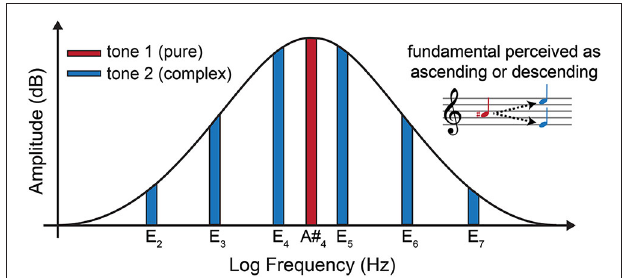
FIGURE 1 | Frequency spectrum diagram of the first (pure) tone (red) and the second (Shepard) tone (blue) of the bistable tritone stimulus employed in the current experiment . The horizontal axis is logarithmic reflecting perceptual as opposed to physical distances between frequencies. The musical staff (upper right) shows the two possible perceived pitch movements from tone 1 to tone 2. Due to the pitch ambiguity of tone 2, listeners perceive this pitch as either E 4 or E 5 , which results in ascending or descending pitch percepts relative to tone